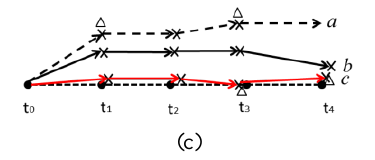
Figure 1. Performance of three solutions under a simulated noisy